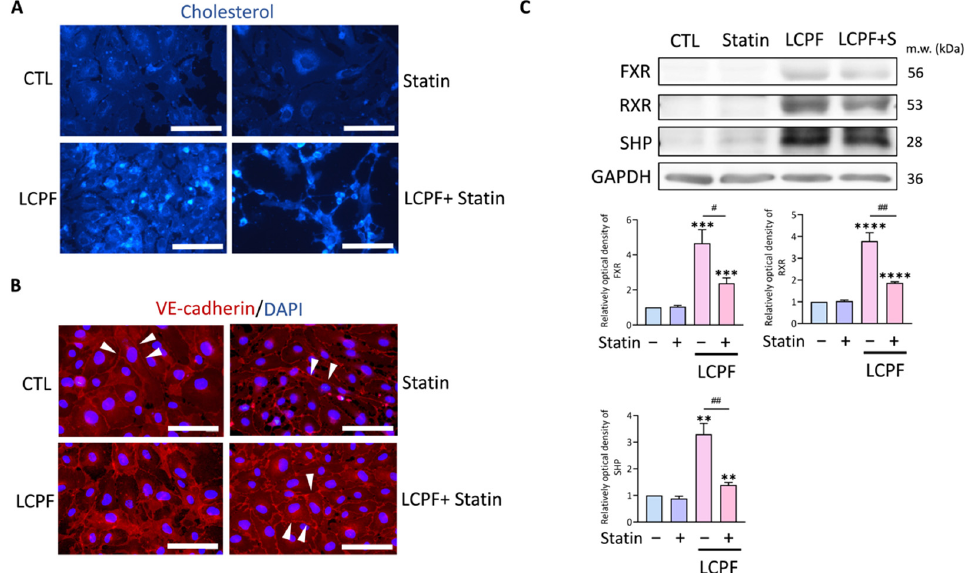
Figure 5. Effect of statin on cellular cholesterol, endothelium junction, and FXR signaling. HUVECs were treated with or without 20 µ M atorvastatin (statin) in the presence of LAPF for 24 h. ( A , B ) HUVECs were processed for immunofluorescence staining of cholesterol (blue) and VE-cadherin (red), respectively. Nuclei are visualized with DAPI. The arrowheads indicate the distribution of VE-cadherin. The magnification is 400×. Scale bar = 100 μ m. ( C ) Proteins in FXR signaling, including FXR, RXR, and SHP, were examined by Western blotting. GAPDH was used as an internal control. ** p < 0.01; *** p < 0.001; **** p < 0.0001, compared to the control group. # p < 0.05 and ## p < 0.01,